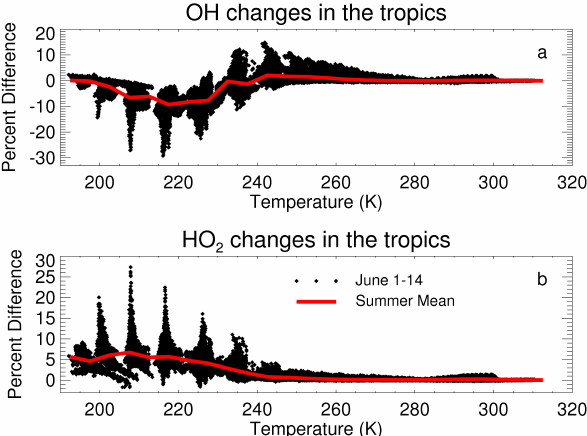
Fig. 7. Differences between the GEOS-Chem base case and MPN case (((MPN-BASE)/BASE)*100) over the tropics versus temper- ature for (a) OH and (b) HO 2 . The individual points are the 24h average value of 1–14 June 2008. The red line is the summer mean concentration. The regular temperature intervals at low tempera- tures are a result of decreasing vertical resolution in the model at increasing